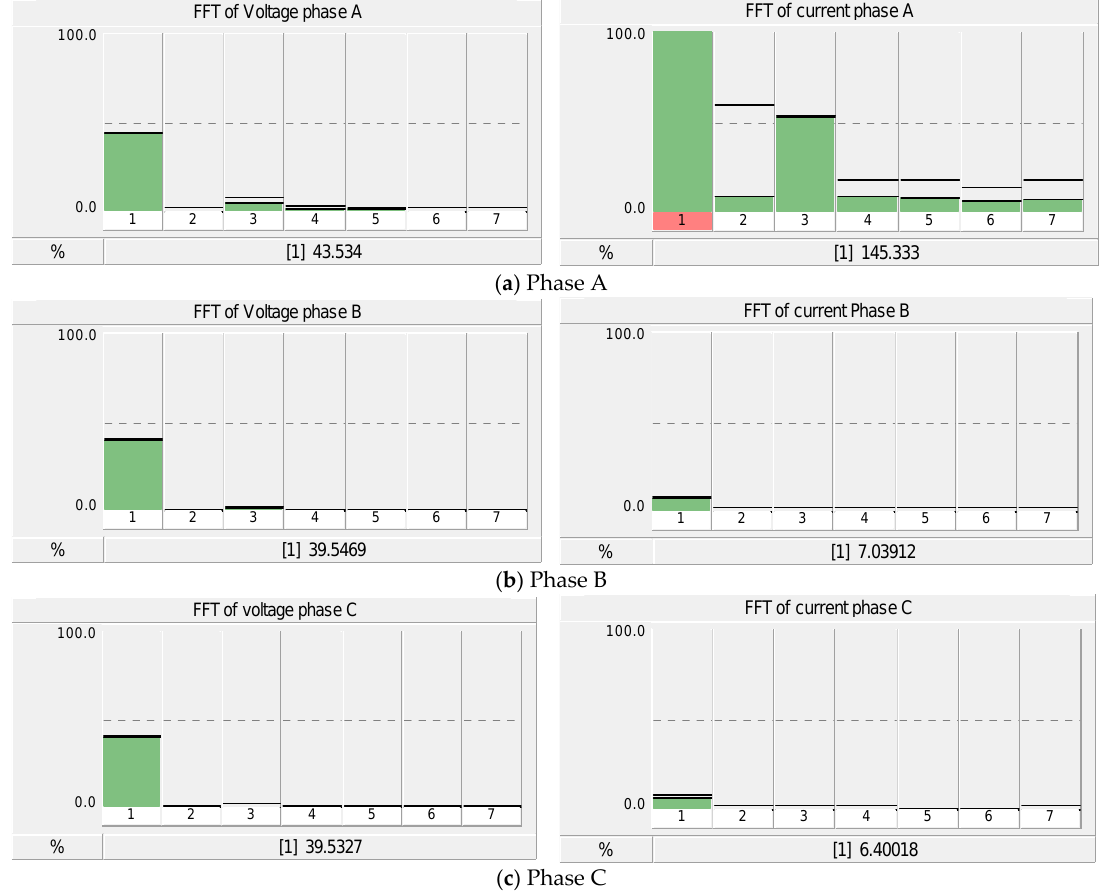
Figure 23. The voltage and current at the LV side (0.4 kV) transformer 500 kVA when the BRKA close circuit is at 0.6 s.